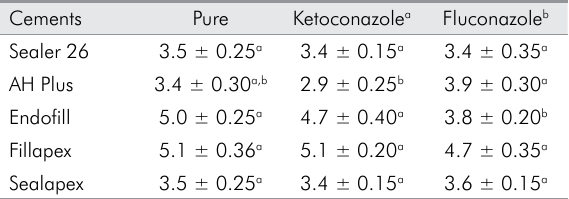
Table 5. Mean and standard deviation in cm of the flow test of sealers, pure and following addition of ketoconazole and